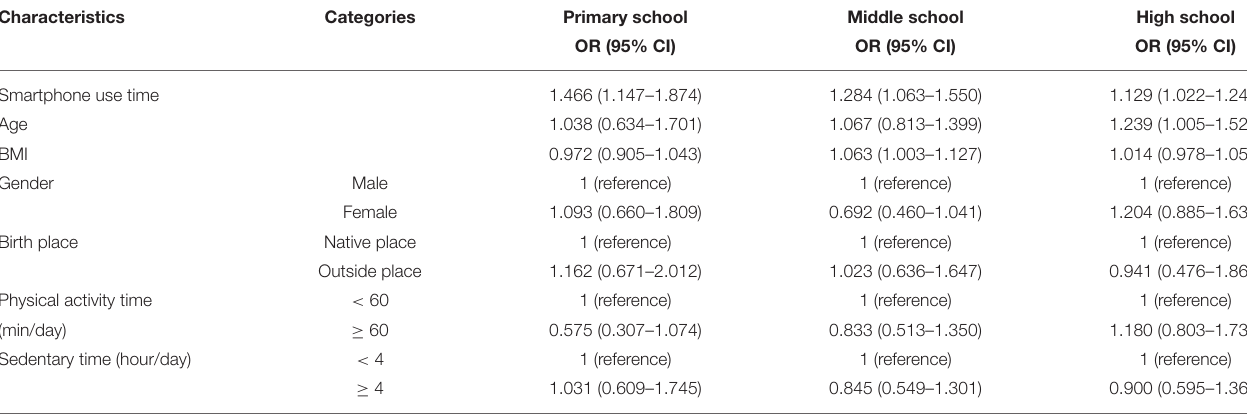
TABLE 4 | Associations between smartphone use time and the abnormal academic stress stratified by grade group. Characteristics